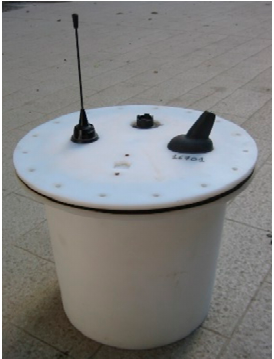
Figure 2. Drifter with GPS and radio antenna equipped.